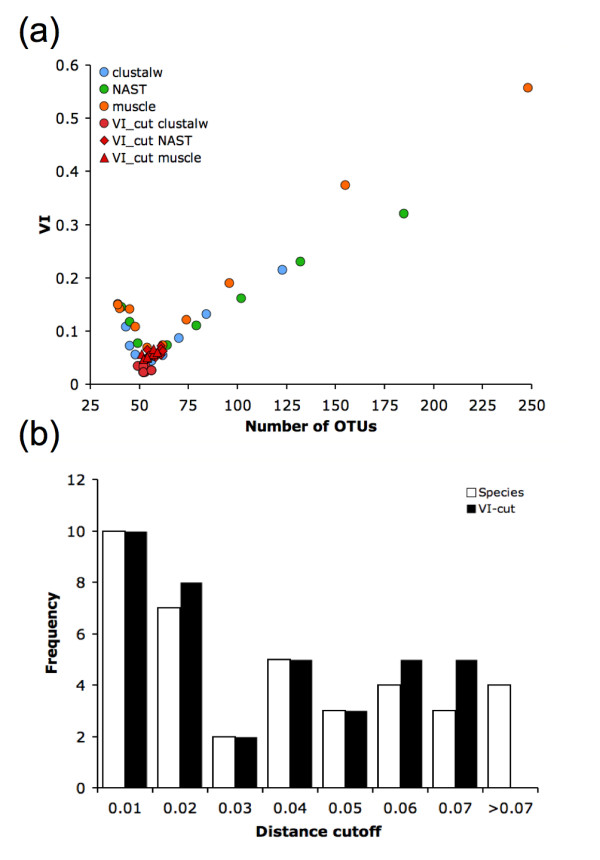
Results of VI-cut compared to standard methodologies. (a) Standard methodologies using a specific MSA with furthest neighbor clustering to find OTUs. VI-cut was employed using the same MSA and distance correction in each plot. For each VI-cut trial, 10% of the sequences were randomly selected and given labels. Over 20 trials, OTUs determined by VI-cut are stable and more accurate than the standard methodologies. (b) Distribution of distances within clusters defined by the species-annotation and a sample VI-cut clustering. Clusters with one member (i.e. singletons) are not shown. There is considerable variation (D = 0.01-0.07) in the optimal distance threshold among species.